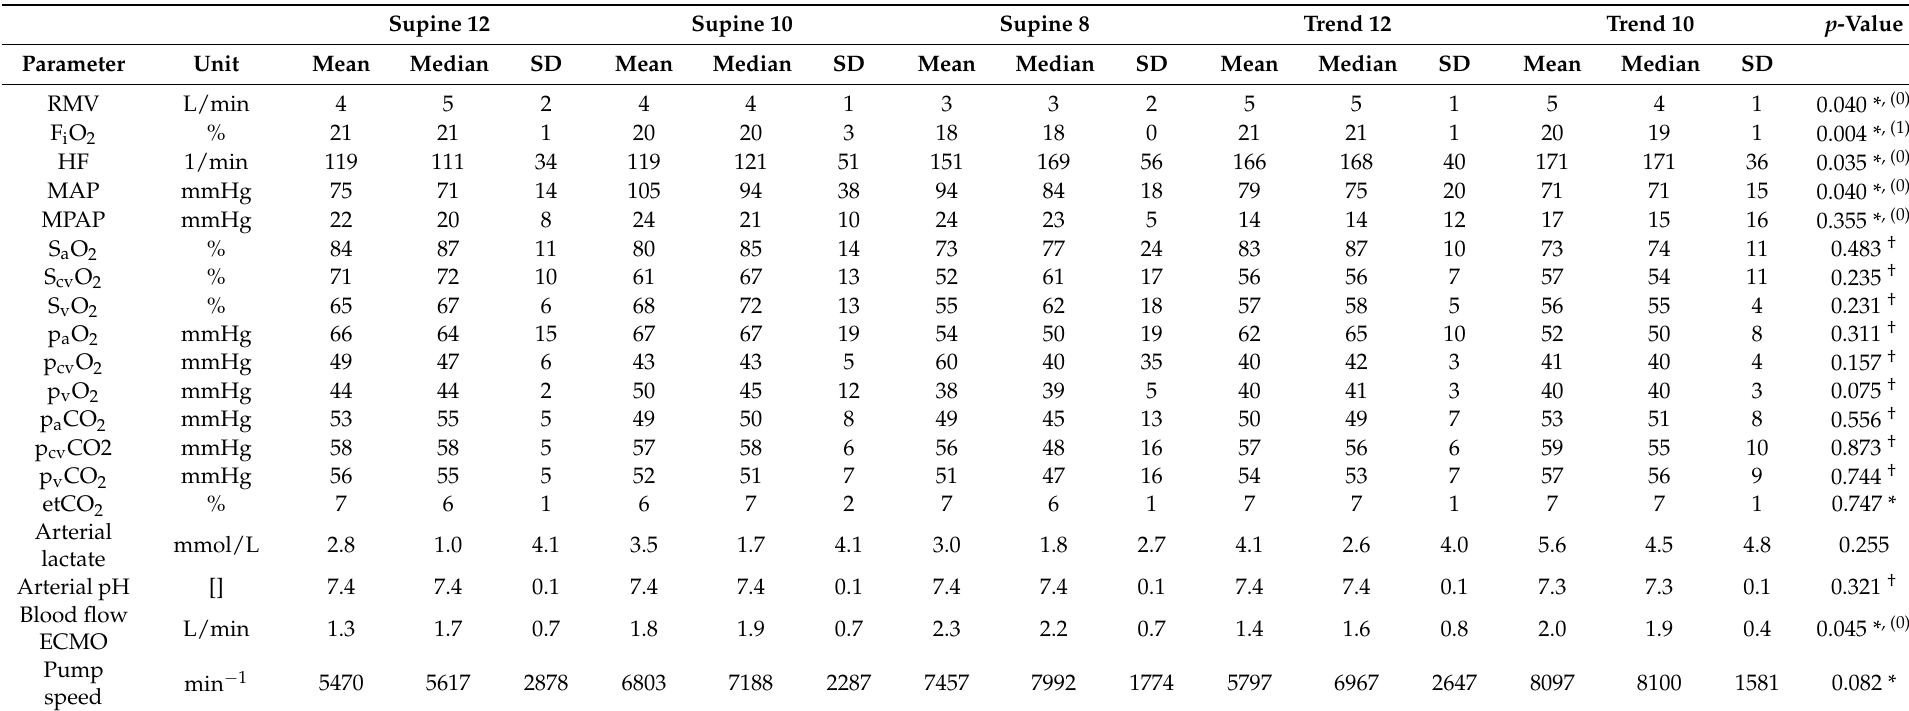
Table 1. Animal trial monitoring. Supine: animal was positioned flat on the back; Trend: 45 ◦ reverse Trendelenburg position, simulating a mobilized patient; and 12,10,8: respiratory rate of the intermittent mechanical ventilation, simulating hypercapnic respiratory failure. RMV = respiratory minute volume; F i O 2 = fraction of inspired oxygen, utilized for simulating hypoxemic respiratory failure; HF = heart frequency; MAP = mean arterial pressure (approximated from end-systolic and end-diastolic pressures); MPAP = mean pulmonary arterial pressure (approximated); S = oxygen saturation, p = partial pressures, et = end tidal/respiratory, ∆ P = membrane pressure drop; fPHb = free plasma hemoglobin; and V = gas transfer. Indices: a = arterial, v = mixed venous at pulmonary artery, and cv = venous at vena cava superior. Carbon dioxide blood contents were calculated using a function by Douglas et al. [29] with a CO 2 -plasma diffusion coefficient of 0.03 mmol/mmHg and an apparent dissociation constant of carbonic acid of 6.1. Oxygen contents were calculated using a function by Leach et al. [30] with the Hüfner-number = 1.34 and with an O 2 -plasma diffusion coefficient of 0.03 mL/mmHg/dL. Significance was tested for all groups using the Friedman test ( * ) with Dunn’s post-test. (0) : No significance between any combination of groups using Dunn’s; (1) : Supine 8 was significantly different to Supine 12 and Trend 12 using Dunn’s. If values were missing within a parameter set, Kruskal–Wallis test was conducted (†) . No parameter and combination of tested groups showed significance for p < 0.05, except for the controlled parameter F i O 2 . The column p -value shows the Friedman/Kruskal–Wallis